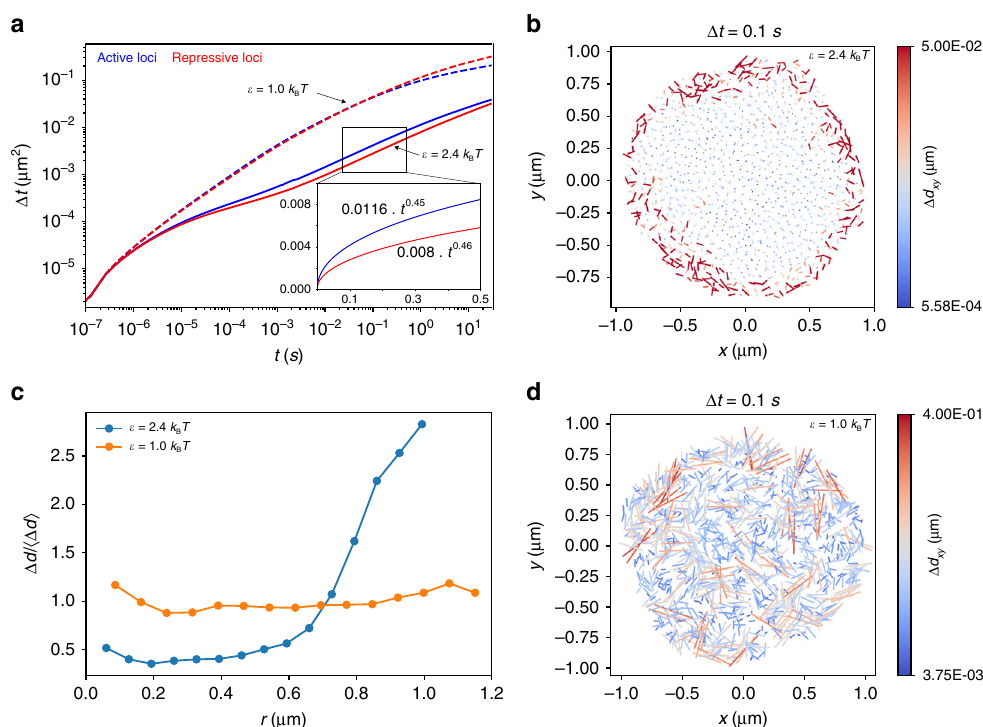
Fig. 8 Mobility of active and repressive loci. a The mean square displacement for active loci and repressive loci. The equation shown in the inset is the fi t using Dt α , where D is the diffusion coef fi cient and α is the diffusion exponent. b The displacement vectors of the loci within the equator cross-section of the structured chromosome for ϵ = 2.4 k B T . The displacements are computed for time window Δ t = 0.1 s. The color bars on the right show the magnitudes of the displacements. c Displacement Δ d normalized by its mean as a function of radial position, r , of the loci. d Same as b except the results are obtained using ϵ = 1.0 k B